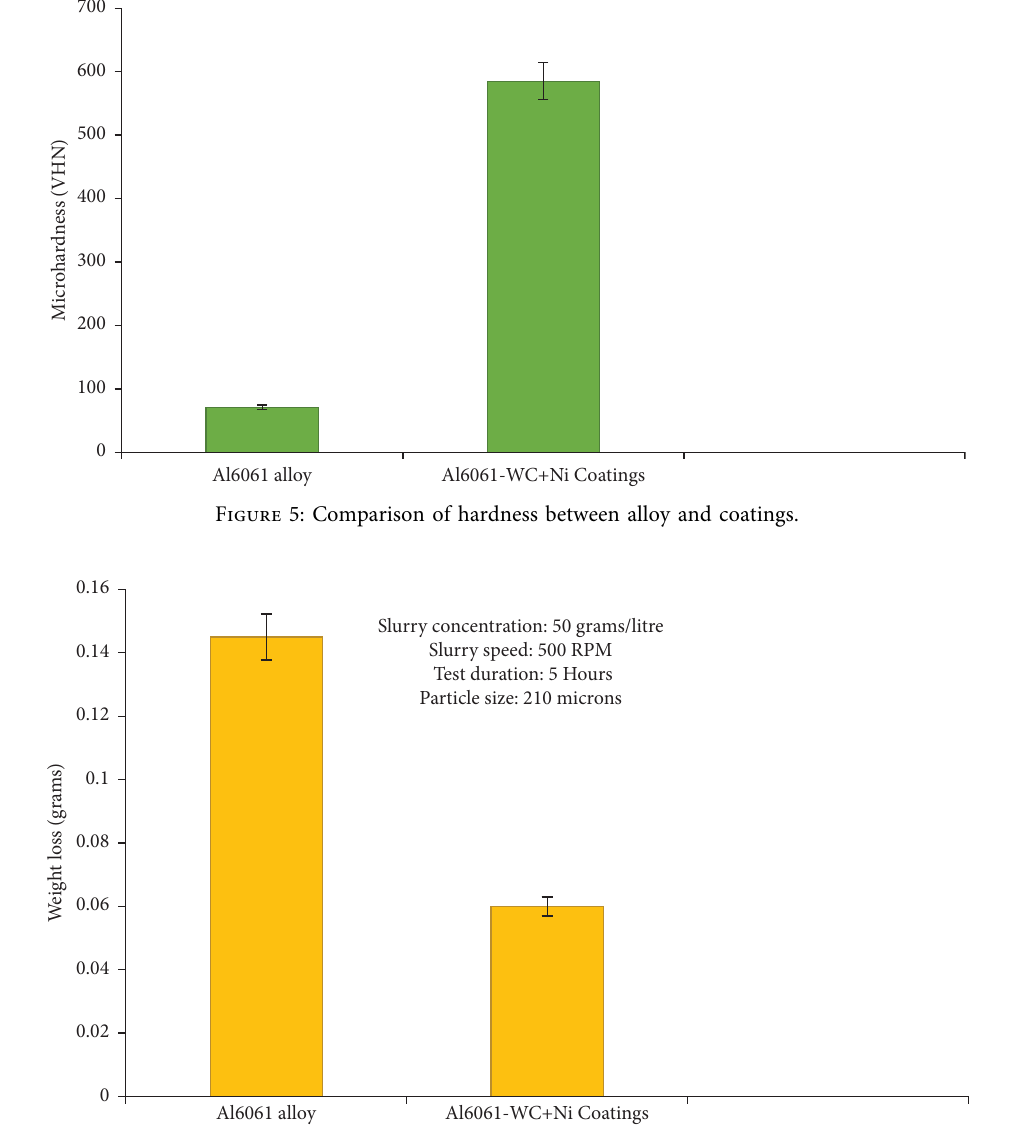
Figure 6: Comparison of slurry erosive wear between alloy and coatings.